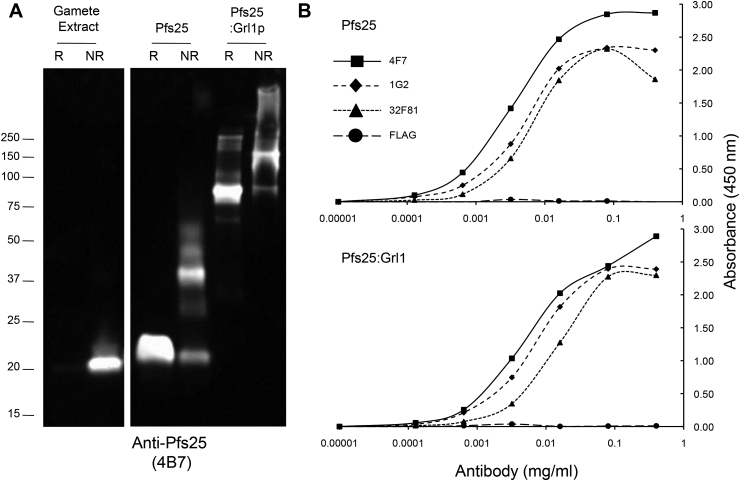
Characterization of Pfs25 and Pfs25:Grl1p epitopes. A. Anti-Pfs25 Western Blot. Purified P. falciparum gametes (500,000 per lane), and 1 μg Pfs25 and Pfs25:Grl1p were resolved by SDS-PAGE under reducing (R) or non-reducing (NR) conditions and analyzed by Western blot with the transmission-blocking mAb 4B7. B. ELISA titration of anti-Pfs25 transmission-blocking antibodies. Pfs25 (Top Panel) and Pfs25:Grl1p (Bottom Panel) were adsorbed to microtiter wells in equimolar amounts with respect to Pfs25. Serial 5-fold dilutions of antibodies that recognize either a linear (32F81) or conformational (1G2, 4F7) Pfs25 antibodies were applied to wells. A non-related antibody (FLAG) was included as a negative control in each analysis.